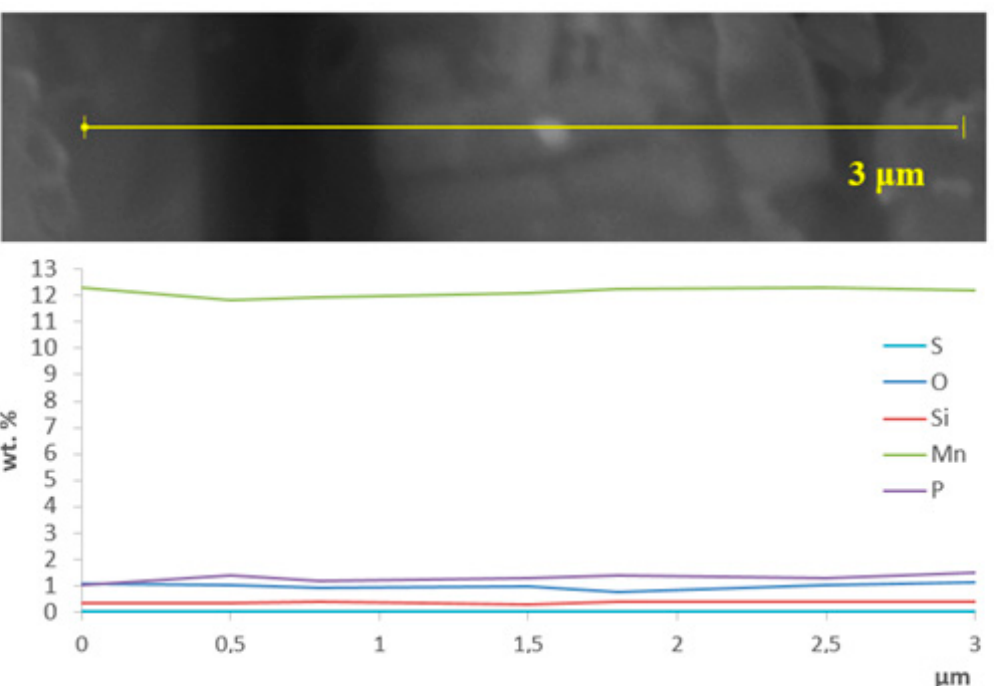
Figure 3. STEM image with EDX analysis of the distribution of elements for a sample of Hadfield steel.